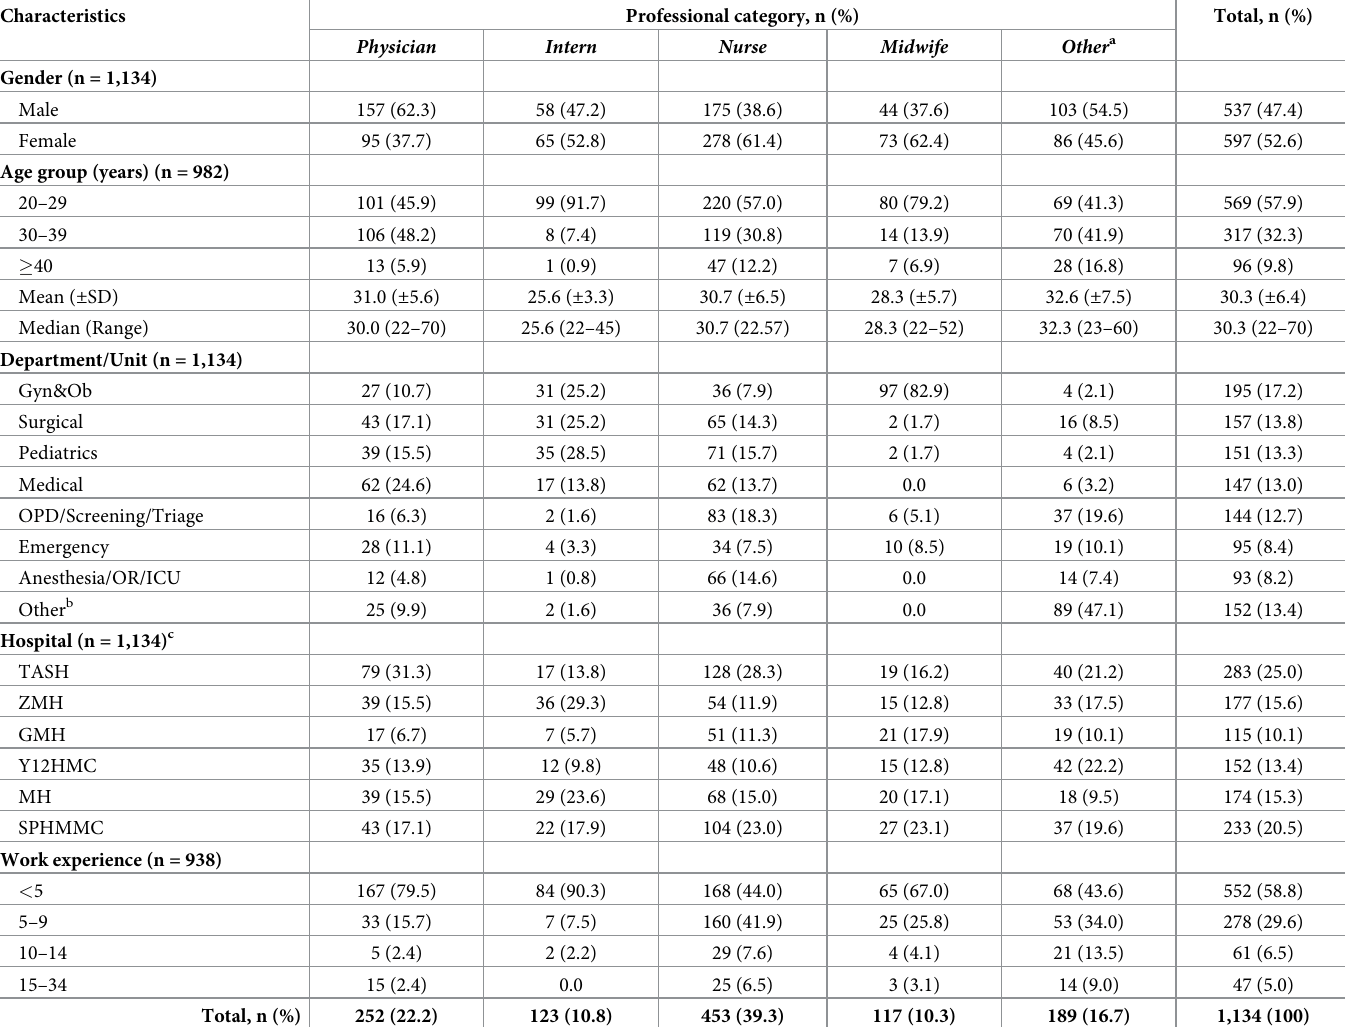
Table 1. Characteristics of study participants by professional category (N =